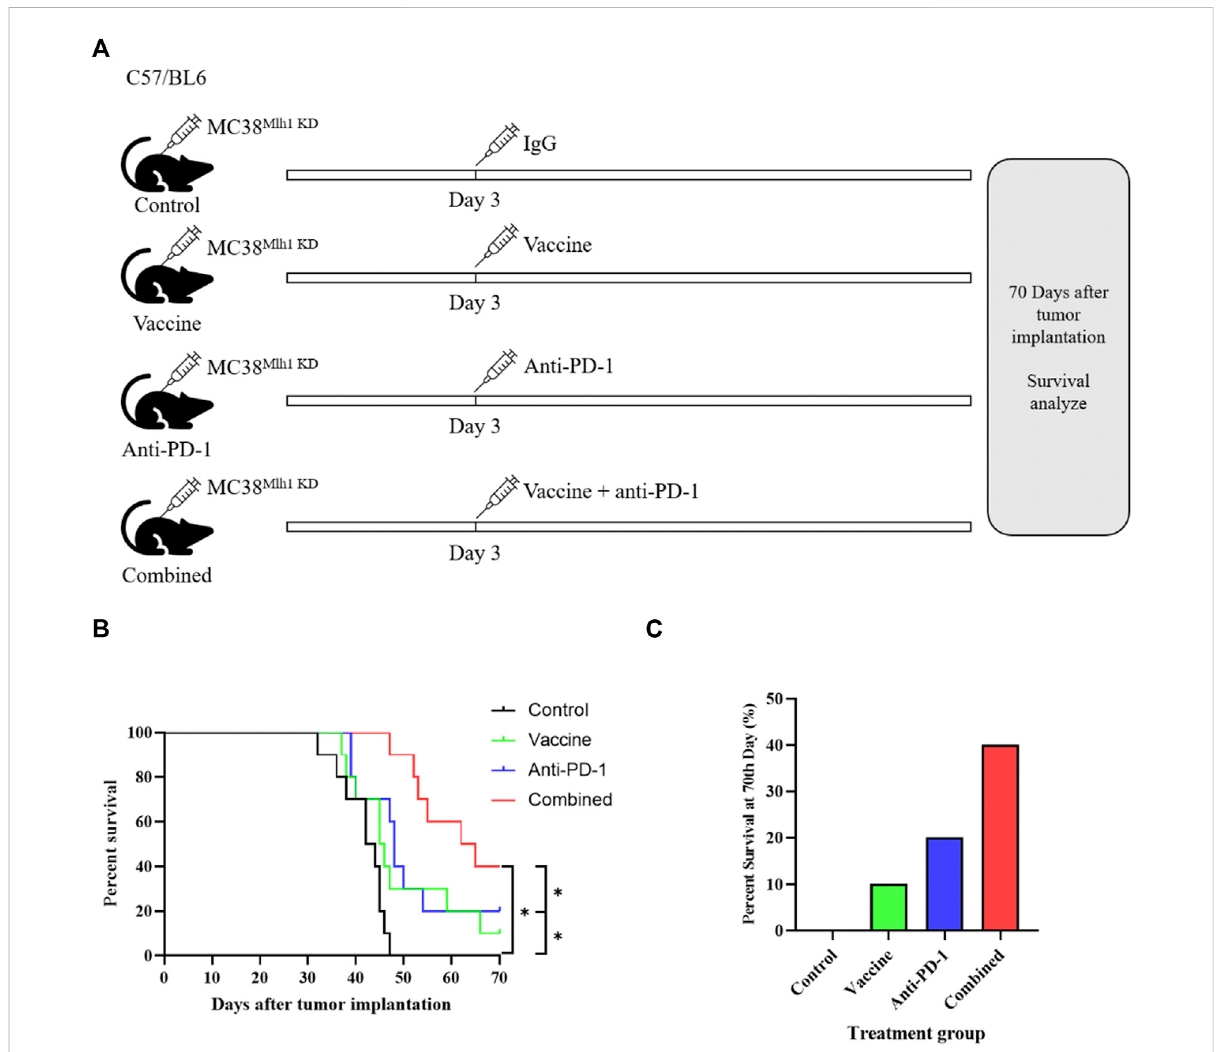
FIGURE 1 Combination therapy with vaccine and PD-1 blockage improves clinical outcomes in the Lynch syndrome colon cancer mouse model. (A) Schemaoftumorimplantation andtreatment (C57/BL6 micewereinjectedwith MC38 Mlh1KD cellsintherightlowerlimbanddividedintofourgroups with ten mice in each group). (B) Kaplan-Meier survival curves of mice that were implanted with MC38 Mlh1 KD colon cells and were treated with different combinations of IgG, Vaccine and PD-1 antibody. (C) The percentages of mice that remained survival at 70th day following tumor implantation and therapy. Statistical signi fi cance was measured using Student ’ s t-test and one-way ANOVA. *, p <